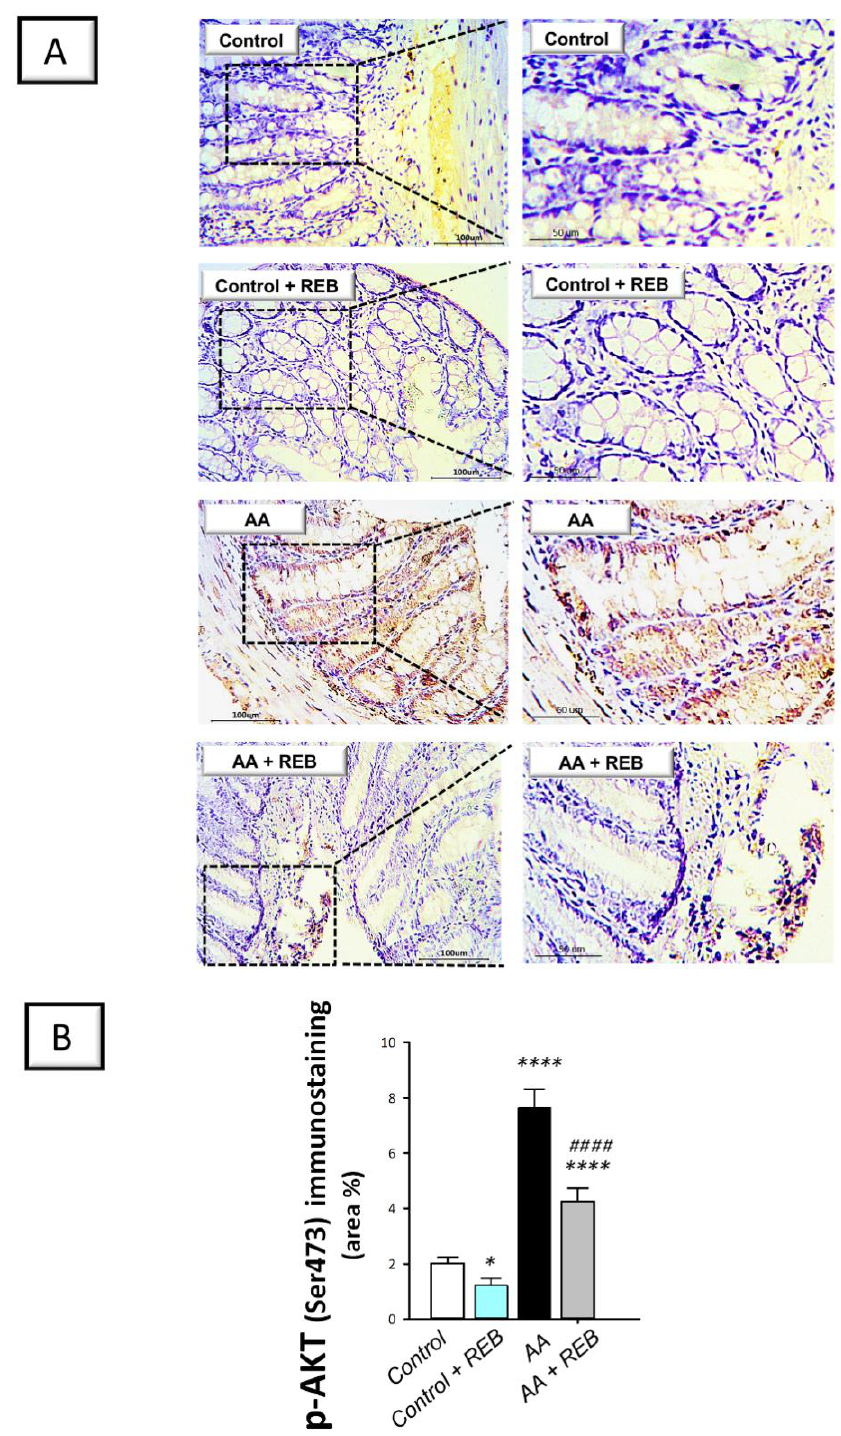
Figure 6. Rebamipide inhibits the colonic PI3K/AKT pathway in rats exposed to acetic acid-induced colitis. ( A ) Immunostaining of the phosphorylated form of protein kinase B (p-AKT(Ser473)) in the colonic tissue. ( B ) Quantification of colonic p-AKT(Ser473) immunostaining. Each bar represents the mean ± S.D. ( n = 6). A one-way ANOVA statistical test was conducted to analyze the significant difference among tested groups followed by a Tukey’s test. * p < 0.05 , or **** p < 0.0001, significant from the control group. # ### p < 0.0001, significant from the colonic injury group. REB, rebamipide; AA, acetic acid.